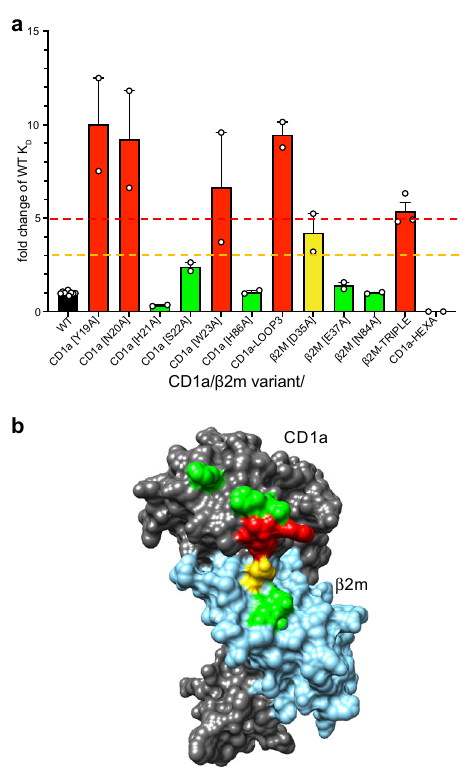
Fig. 6 Energetic landscape of CD1a-CO3 γδ TCR interaction. a SPR was used to measure the binding af fi nity between CO3 γδ TCR and CD1a containing single or multiple mutations across the CO3-CD1a complex interface. Green (K D change < 3-fold), orange (3 to 5-fold decrease in K D ) and red (>5-fold decrease in K D ) bars summarise the change in the interaction between CO3 γδ TCR and CD1a mutants with respect to the wild-type CD1a protein (black bar, K D = 24 μ M). The values were calculated from at least two independent experiments ( n ≥ 2). The error bars correspond to SEM. b Residues involved in the CO3-CD1a complex formation on the surface of CD1a (dark grey)/ β 2m (blue) are coloured based on the mutation analysis shown in a . Amino acids critical for the recognition (red) by CO3 γδ TCR correspond to the Tyr19-Trp23 loop of CD1a. Source data are provided as a Source Data fi